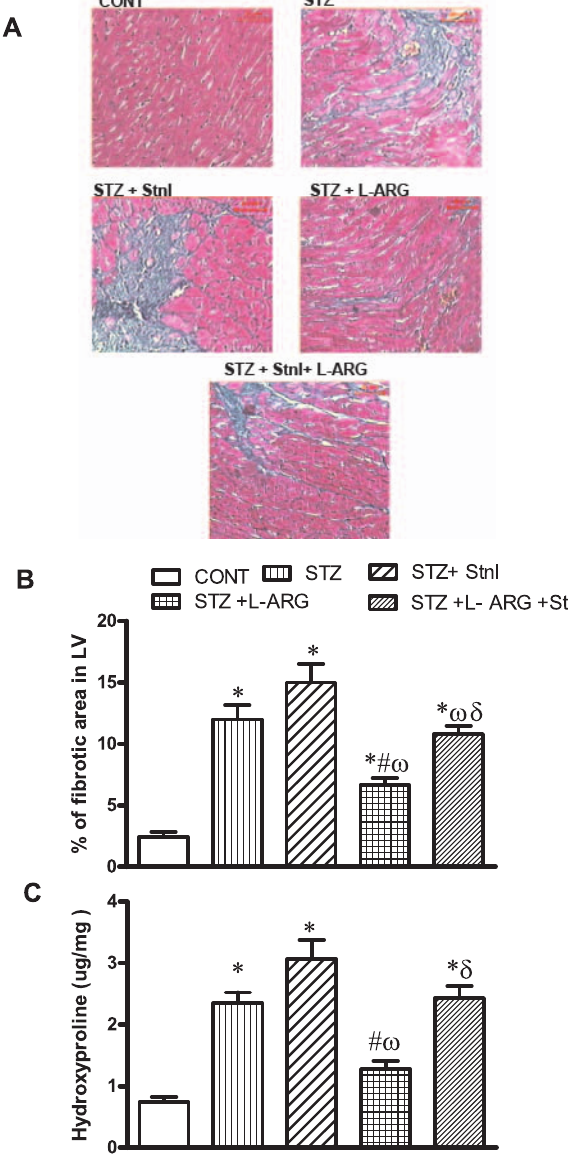
Fig. 1. Effect of STZ alone or in combination with Stnl, L-ARG or Stnl + L-ARG on incidence of fibrosis depicted histopathologically (A) and (B) % of fibrotic area in left ventricle (LV) as well as (C) LV hydroxylproline content. Data represent the means of six experiments ¡ SEM; *, # , v and d P , 0.05 compared with CONT, STZ, STZ + Stnl and STZ + Stnl + L-ARG, respectively, using one-way ANOVA followed by Tukey’s Multiple Comparison